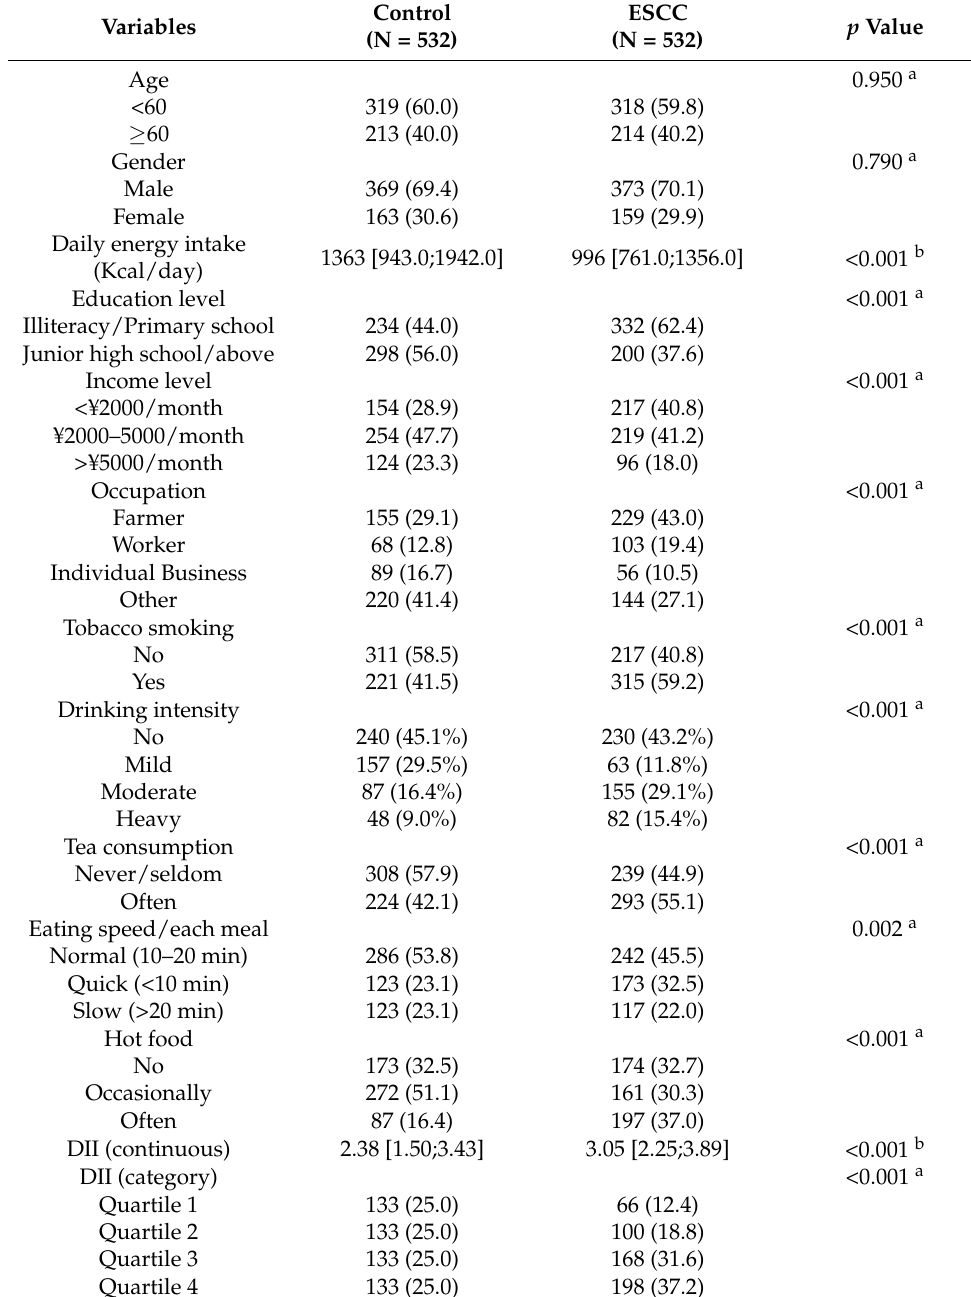
Table 1. Baseline Demographic Characteristics of the Analyzed Participants Given [Median (IQR) or Frequency